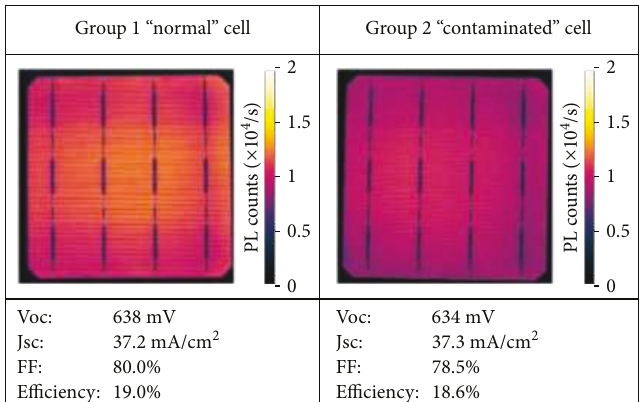
Figure 4: PL image and IV characteristics of a group 1 normal cell and group 2 contaminated cell solar cell after light soaking for 48 hours.